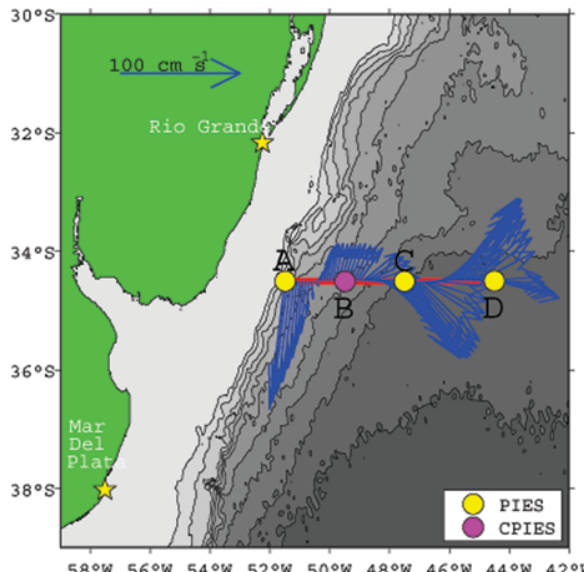
Fig. 1. Map indicating the location of the four PIES/CPIES making up the pilot array. Blue vectors indicate the water velocity at 21m measured via shipboard acoustic Doppler current profiler on the Brazilian naval research vessel N. H. Cruzeiro do Sul in March 2009 during the array deployment cruise. Black letters indicate site names – instrument types are noted in